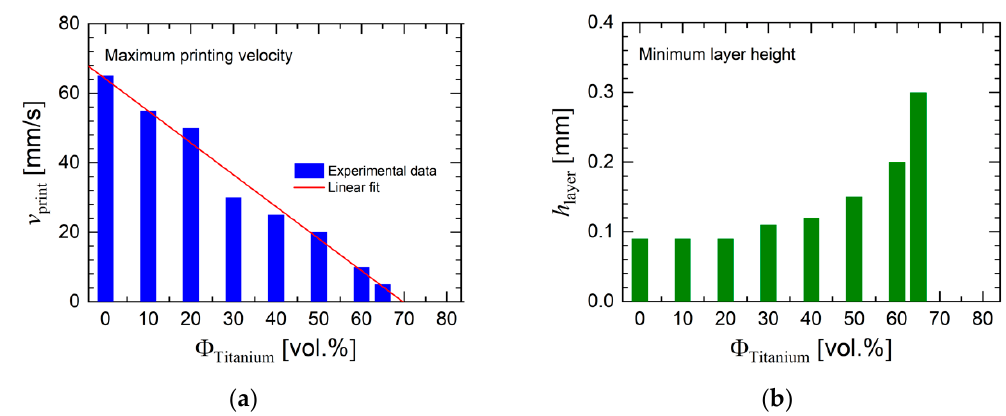
Figure 13. Influence of powder concentration on ( a ) printing velocity and ( b ) minimum layer height for the series of titanium feedstocks.